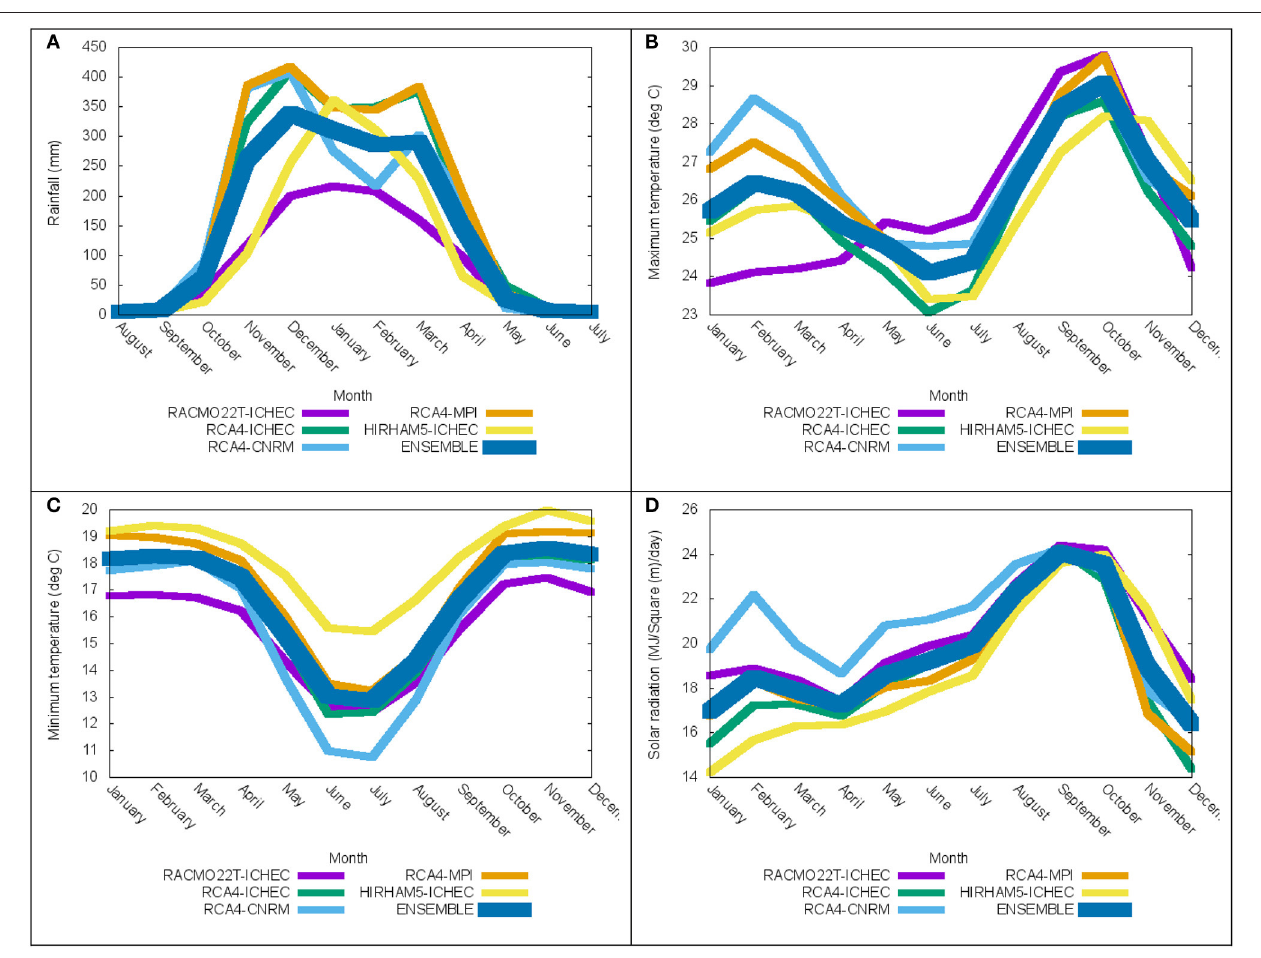
FIGURE 7 | Long-term (2040–2069) annual cycle of climate variables over southern and western highlands sub-agro ecological zones of Tanzania under RCP4.5 (A) rainfall, (B) maximum temperature, (C) minimum temperature, and (D) Solar radiation.